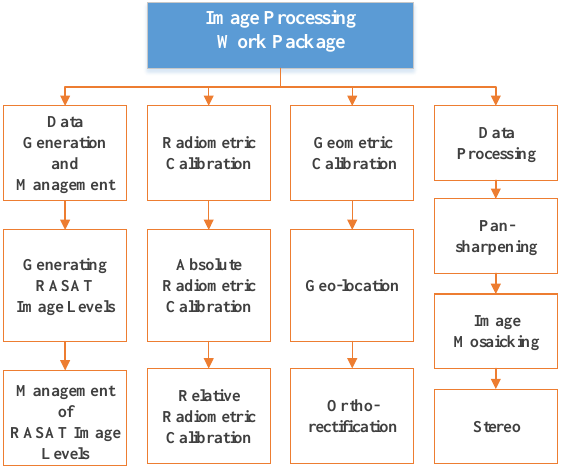
Figure 3. Image Processing Work Package